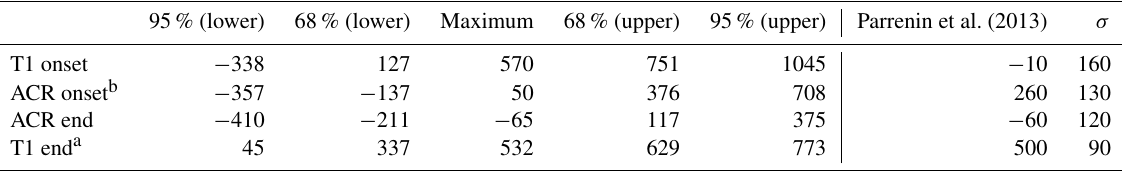
Figure 5. Atmospheric CO 2 (black) and individual δ 18 O records placed on a common timescale, with the normalized histograms of probable change points (eight points) for each ice core used in the ATS3 stack; the locations of the drill sites are shown in the top right corner. Details of the histogram plots are as in Fig. 3. Maximum probability estimates and 68% and 95% probability intervals for timings of the individual records are provided in the Supplement. The δ 18 O records are given in per mill anomalies with respect to the last 200 years, as is the ATS3 stack. Table 1. Maximum probabilities and central probability intervals for leads and lags at each of the selected change point intervals. Negative x -axis values indicate a CO 2